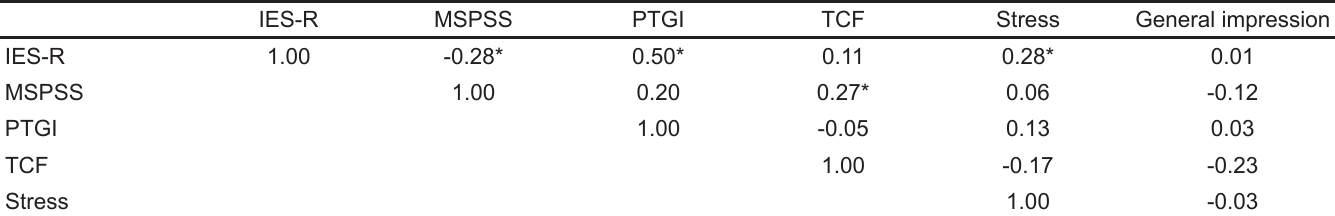
Table 5. Pearson correlation matrix for scales, stress, and general impression of event on graduate medical